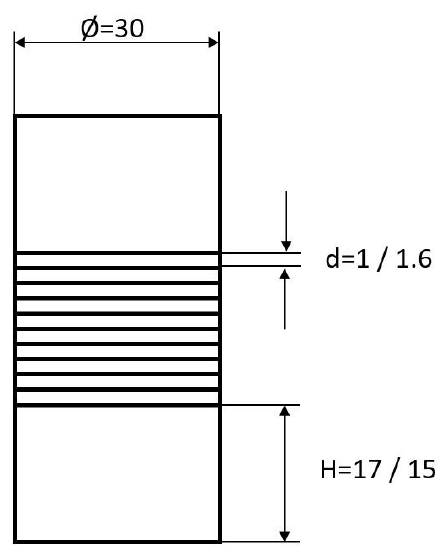
Figure 1. Temperature profile of the used diffusion bonding furnaces.